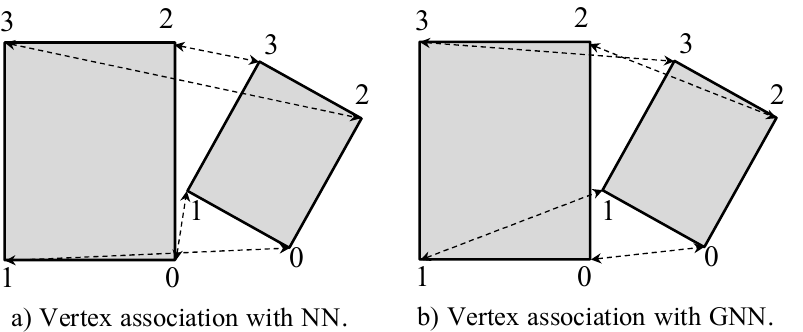
Figure 4. Example of the difference between the association using NN and GNN. On the left, the result using NN, being a local minimum where the vertices are mismatched. On the right, the results obtained using GNN, where the vertices are correctly matched to obtain a global minimum of distances between